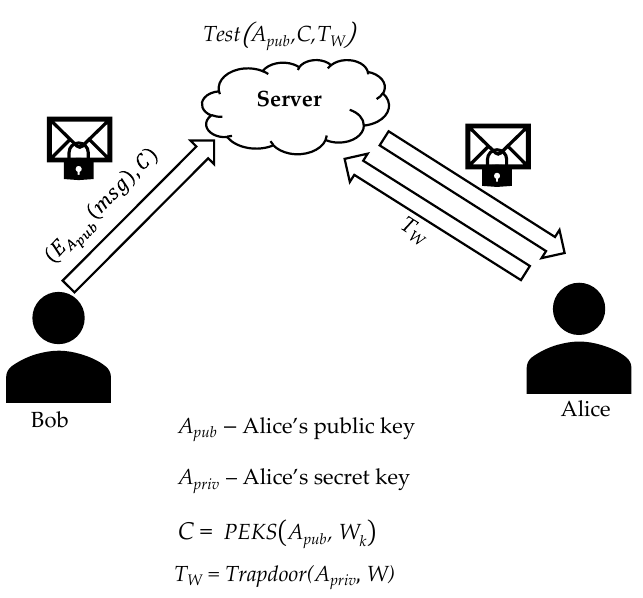
Figure 4. Public key encryption with keyword search (PEKS) system